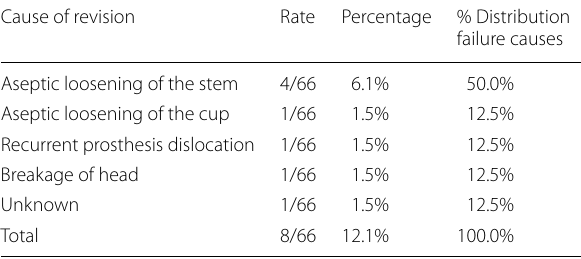
Table 2 Cause of revision in Paget’s patients, report from